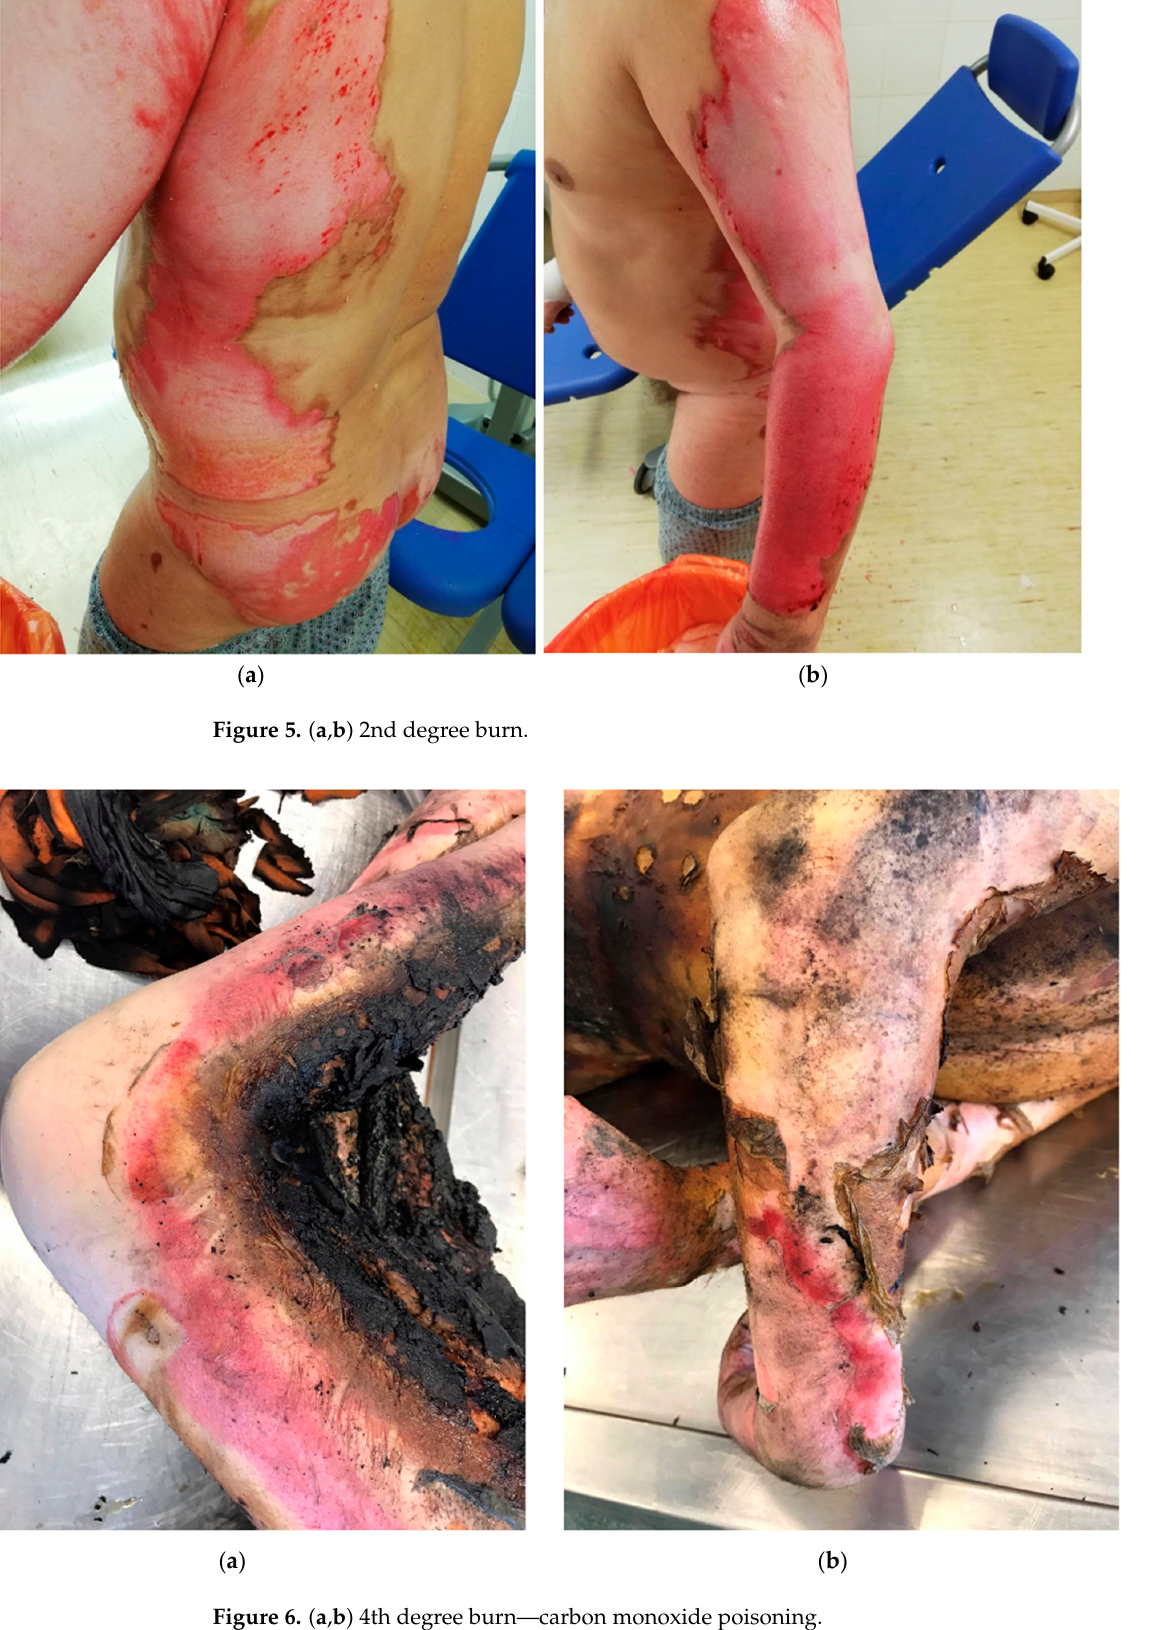
Figure 6. ( a , b ) 4th degree burn—carbon monoxide